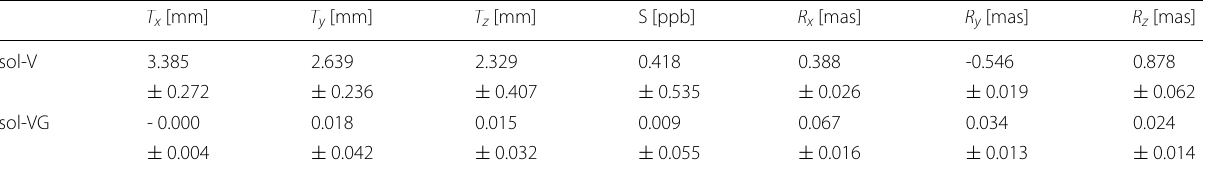
Table 5 Translation, scale and rotation parameters between the a priori and the realized frames, as retrieved by an LSQ estimator based on the Helmert